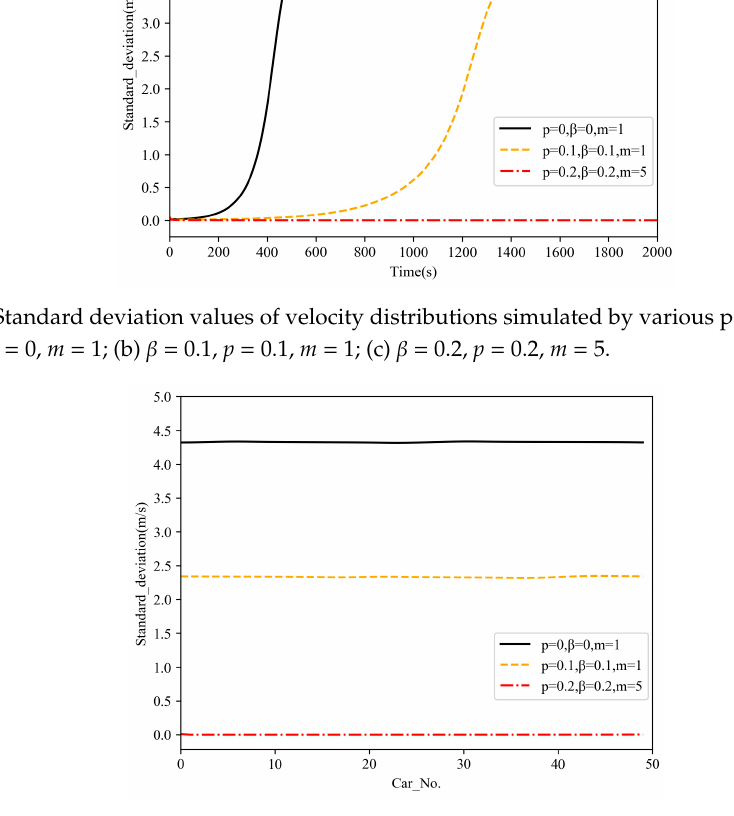
Figure 5. Standard deviation of the velocity of each car simulated with various parameter values.